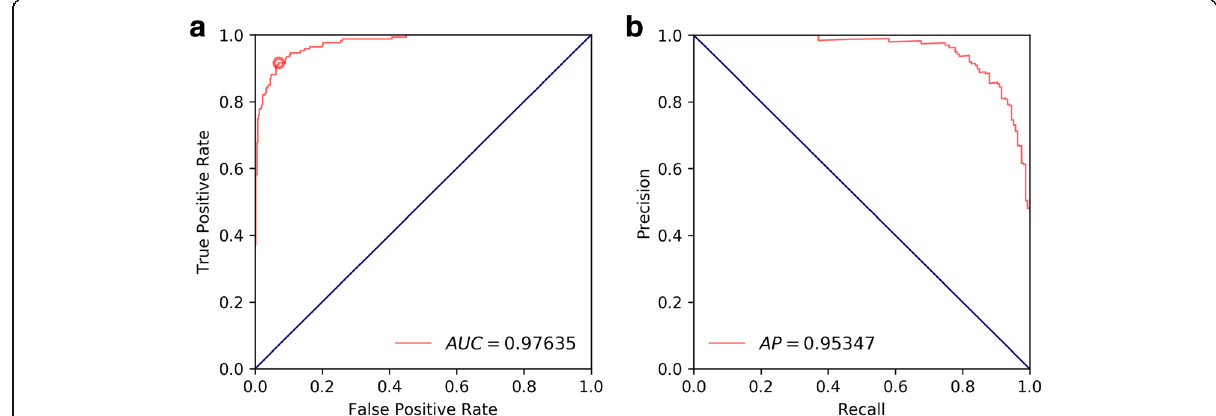
Fig. 8 Volume-level pneumothorax detection accuracy evaluation. a Receiver operating characteristic curves and corresponding area under curve value (specified in parentheses). b Precision-recall curve and corresponding average precision value (specified in